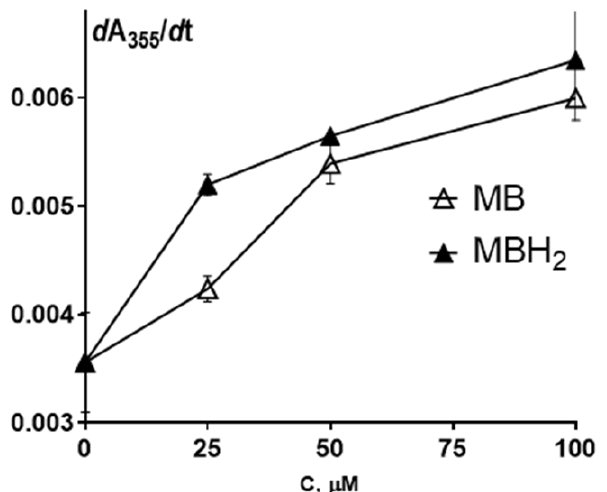
Figure 6. The dependence of the tubulin polymerization rate on MB and MBH 2 concentration. Tubulin polymerization was monitored by recording the change in absorbance at λ = 355 nm. The slope of the linear portion of the curve, d A 355 / d t, is plotted vs. MB and MBH 2 concentration. Each point is the mean ± SEM ( n = 5).